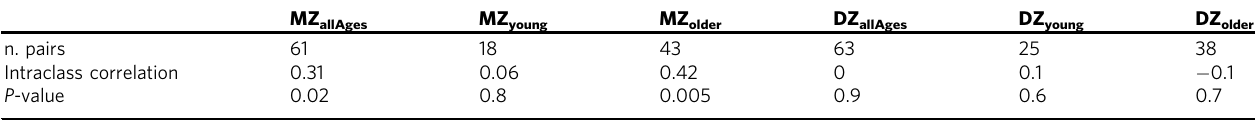
Table 5 Intraclass Spearman ’ s correlations of XCI skew in blood-derived tissues in age strati fi ed twin pairs.